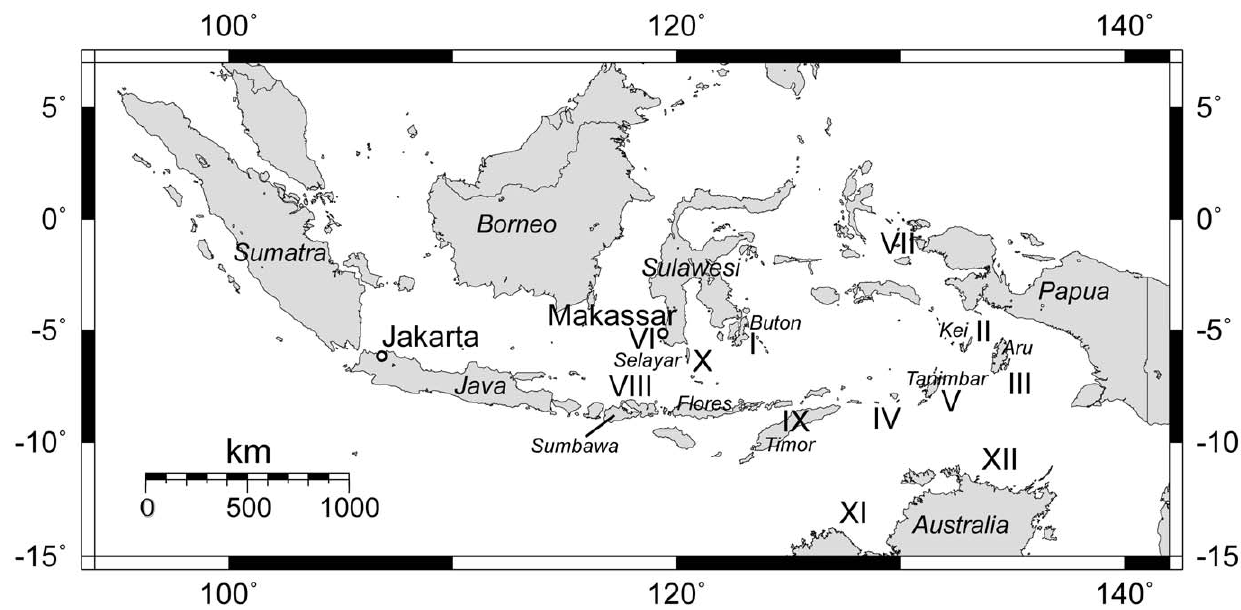
Figure 1. Map of Indonesia, showing important trepang collection areas. The roman numbers refer to passages in the text.